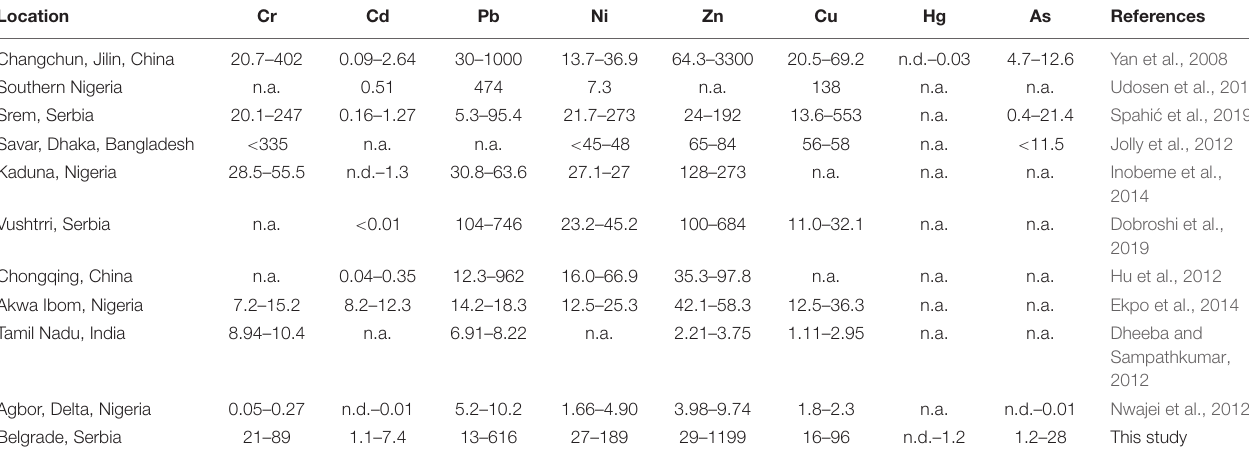
TABLE 3 | Comparison (min-max) of the metal content (mg/kg) in soil samples with other studies from painting industry sites. Location